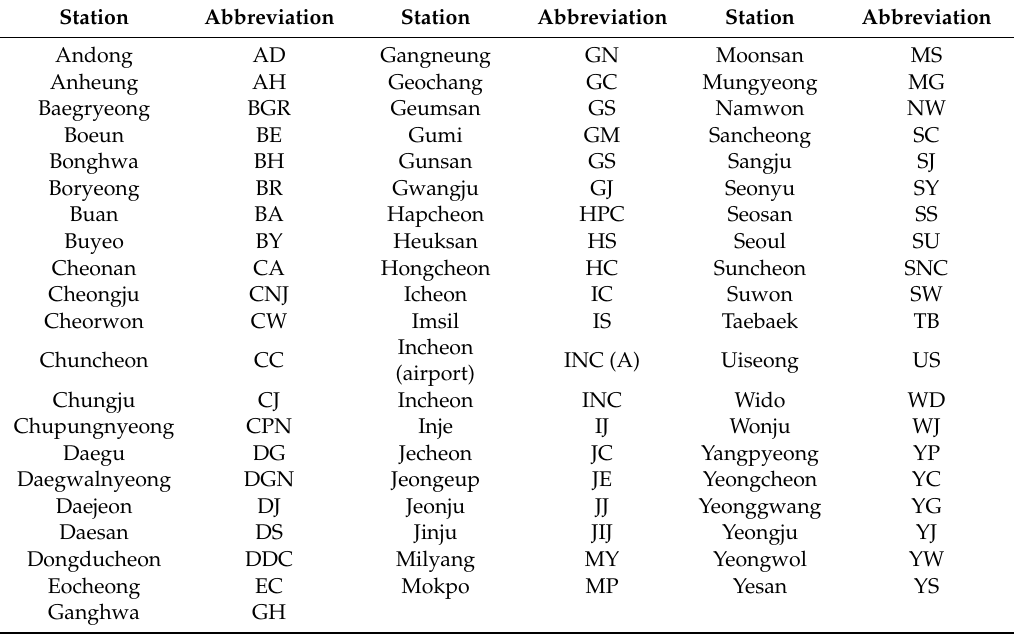
Figure 2. Location of the automatic weather stations (AWSs) and the tidal stations. Table 2. Abbreviation of AWSs and tide stations.